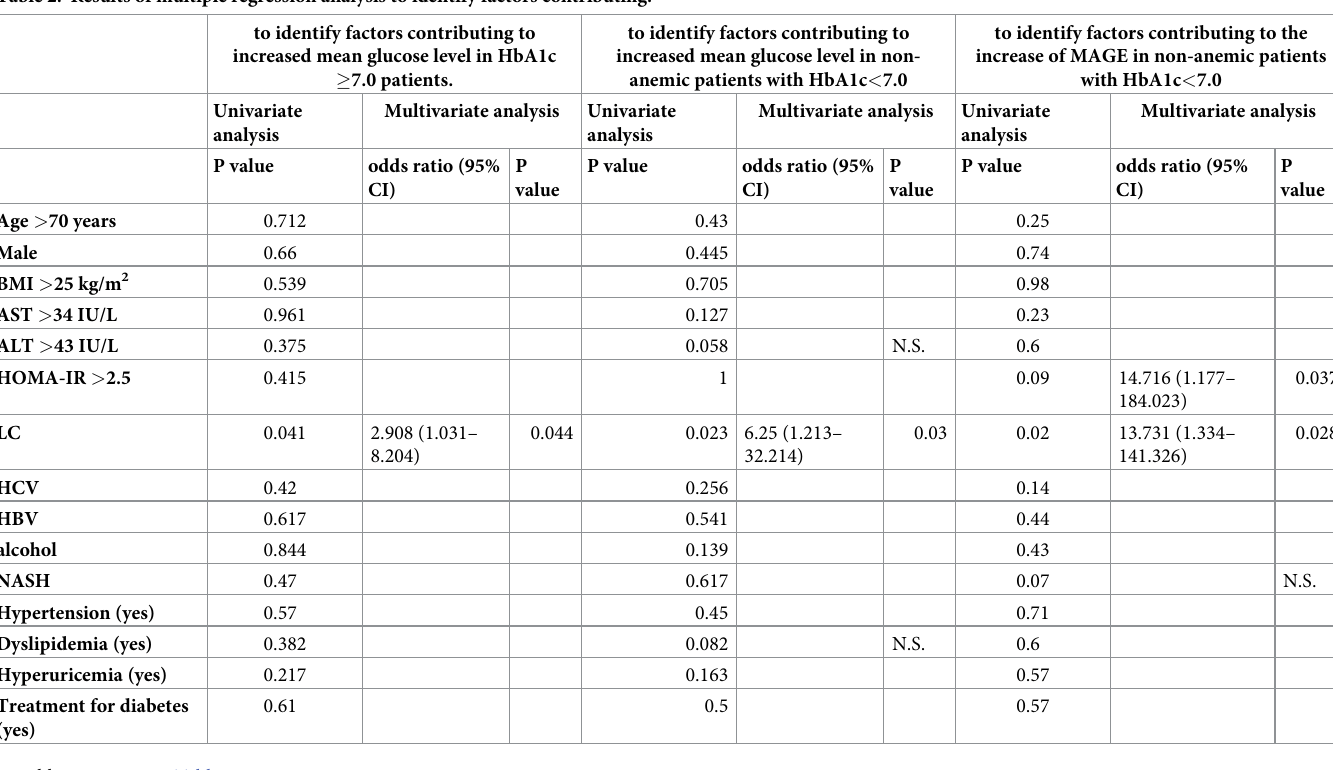
Table 2. Results of multiple regression analysis to identify factors contributing. to identify factors contributing to to identify factors contributing to increased mean glucose level in HbA1c increased mean glucose level in non- (cid:21) 7.0 patients. anemic patients with HbA1c < 7.0